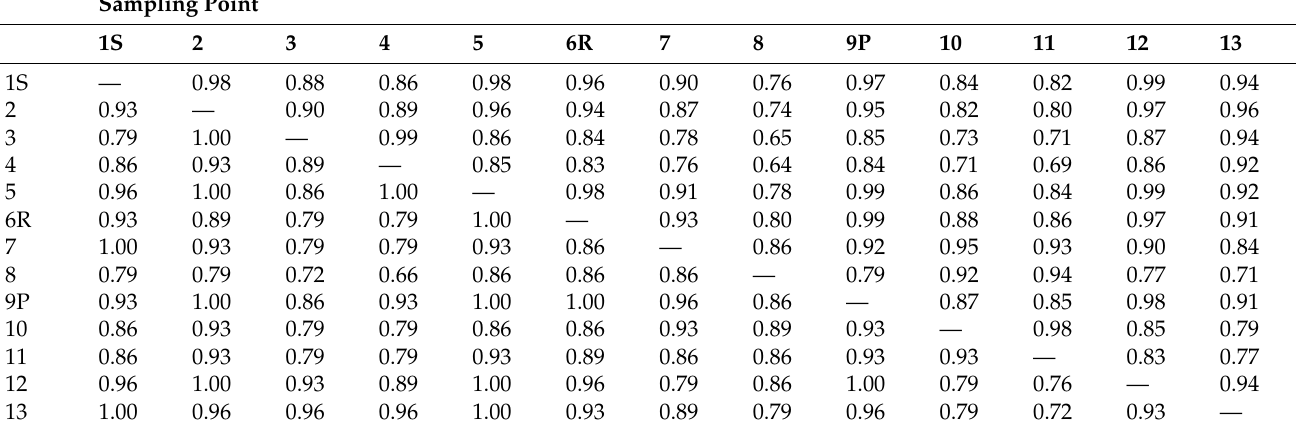
Table 3. The results of multiple-sample ANOVA Mann–Whitney (lower diagonal) and Dunnet post hoc (upper diagonal) tests evidence small differences between the mass fraction distribution of major elements in all 13 samples. Probabilities equal and greater than 85% are illustrated with red ink.